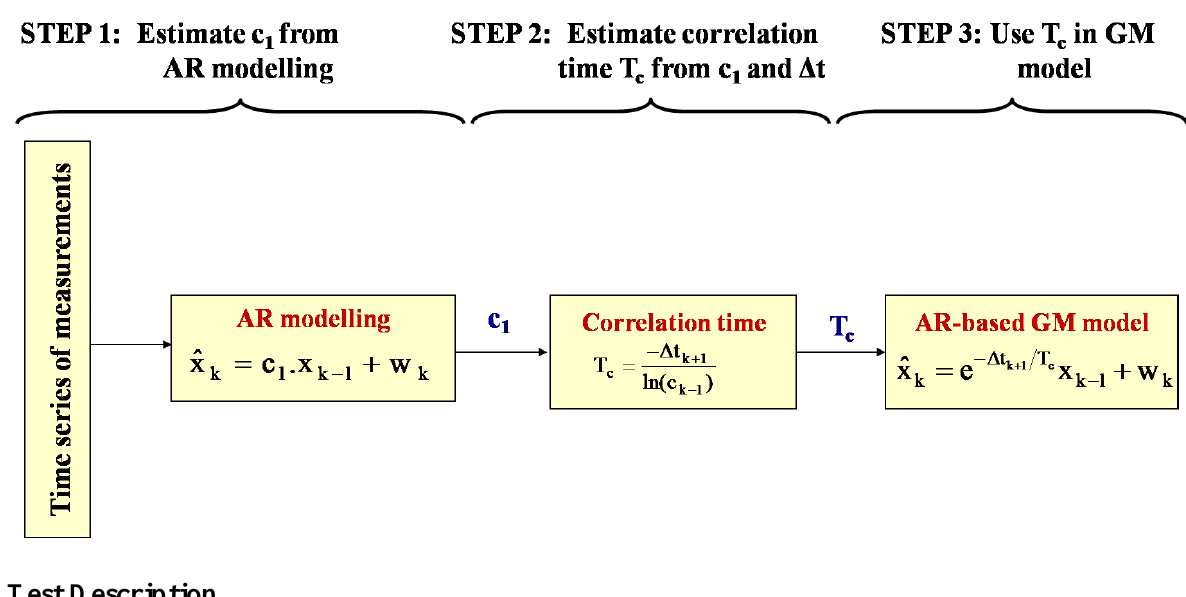
Figure 3. AR-based GM stochastic modelling